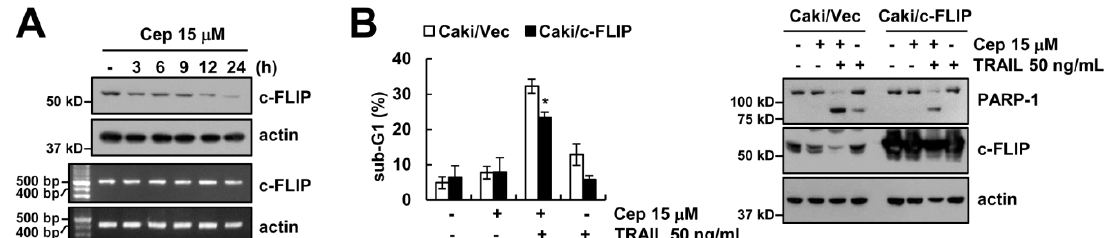
Figure 3. Downregulation of c-FLIP is partially involved in CEP plus TRAIL-induced apoptosis. ( A ) Caki cells were treated with 15 μM CEP for 3–24 h. The c-FLIP expression levels were determined by Western blotting and RT-PCR; ( B ) Vector cells (Caki/Vec) and c-FLIP-overexpressed cells (Caki/c-FLIP) were treated with 15 μM CEP and/or 50 ng/mL TRAIL for 18 h. The sub-G1 population and protein levels were detected by flow cytometry and Western blotting, respectively. Data represent the mean ± SD of at least three independent experiments. * p < 0.05 compared with the CEP plus TRAIL-treated Caki/Vec.